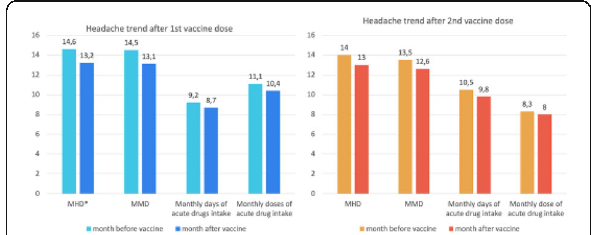
Fig. 2 (abstract P79). Headache features in the month before and after the 1 st and 2nd dose of COVID-19 vaccine. MHD: monthly